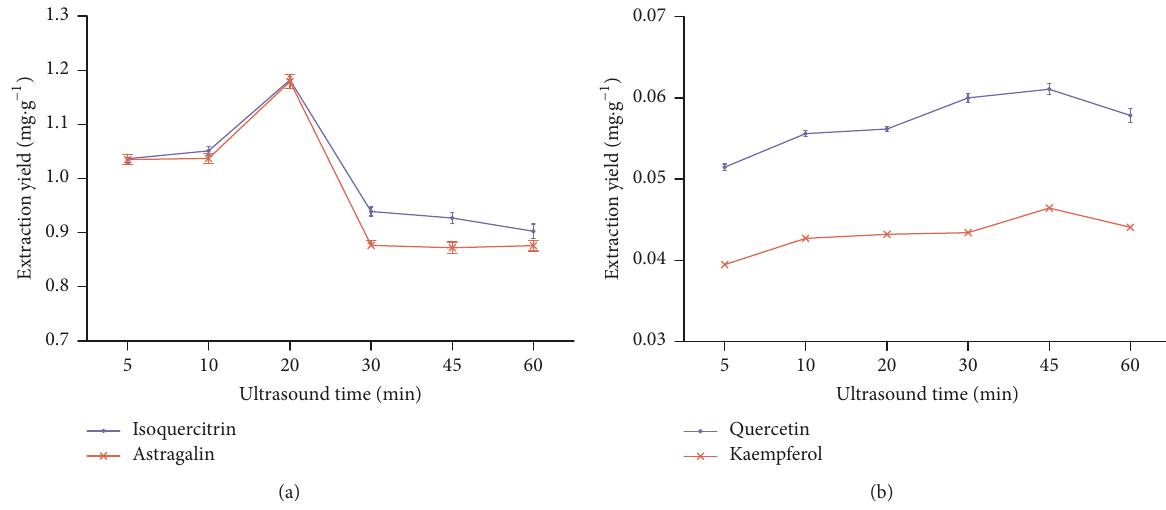
Figure 7: Effect of ultrasound time on extraction yields. Type of IL: [BMIM]BF 4 ; concentration: 0.5 mol ⋅ L −1 ; the particle size: 24 mesh (a) and 40 mesh (b); solid-liquid ratio: 1: 10g ⋅ mL −1 (a) and 1:20 g ⋅ mL −1 (b); ultrasound power: 500W; centrifugation speed: 5000 r ⋅ min −1